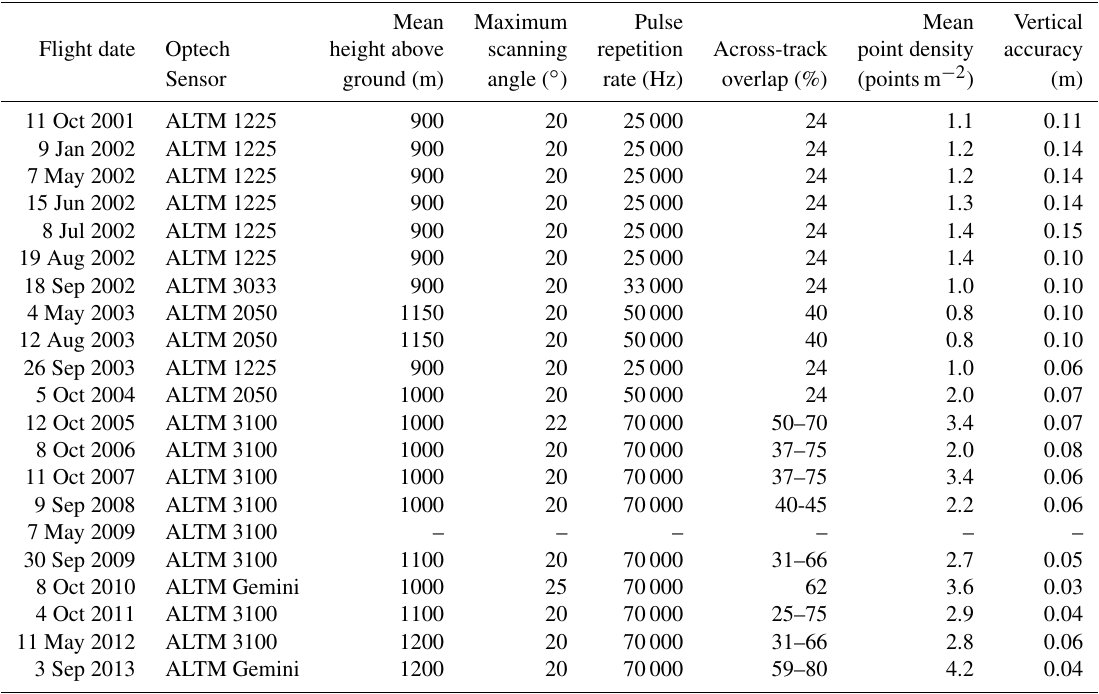
Table 7. Overview of the available HEF ALS data with flight date, used Optech sensor, mean flight height above ground (m), maximum scanning angle ( ◦ ), pulse repetition rate (Hz), across-track overlap (%), mean point density (pointsm − 2 ) and vertical accuracy (m). Data are available at